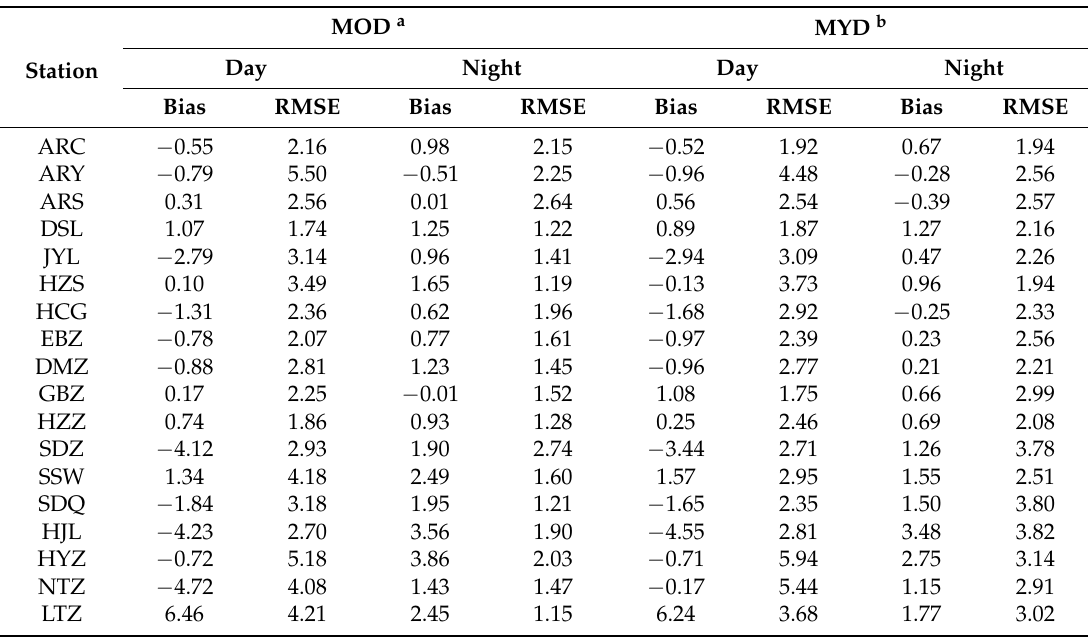
Table 3. Summary of the statistical comparison results between the MODIS LSTs and the LST measurements from the HiWATER